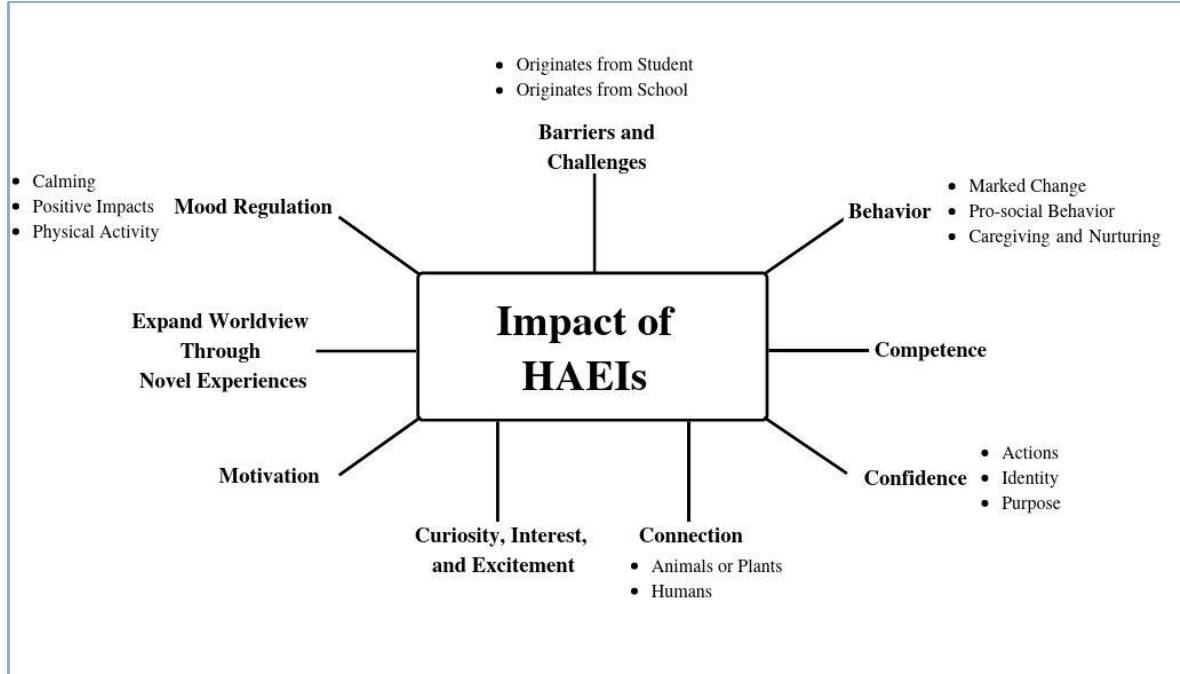
Figure 1. Nine Major Themes With Subthemes That Arose From the Data Analysis